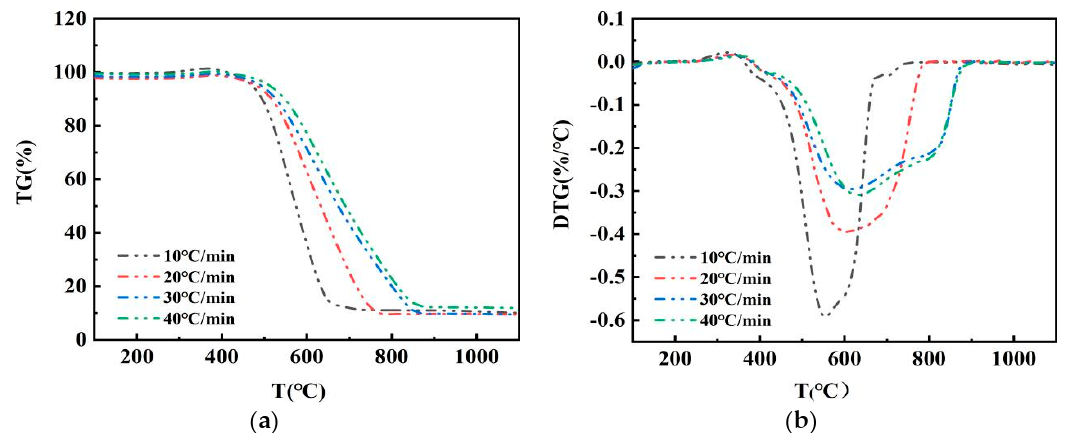
Figure 6. (a) TG and ( b ) DTG curves for different heating rates. Figure 6. ( a ) TG and ( b ) DTG curves for different heating